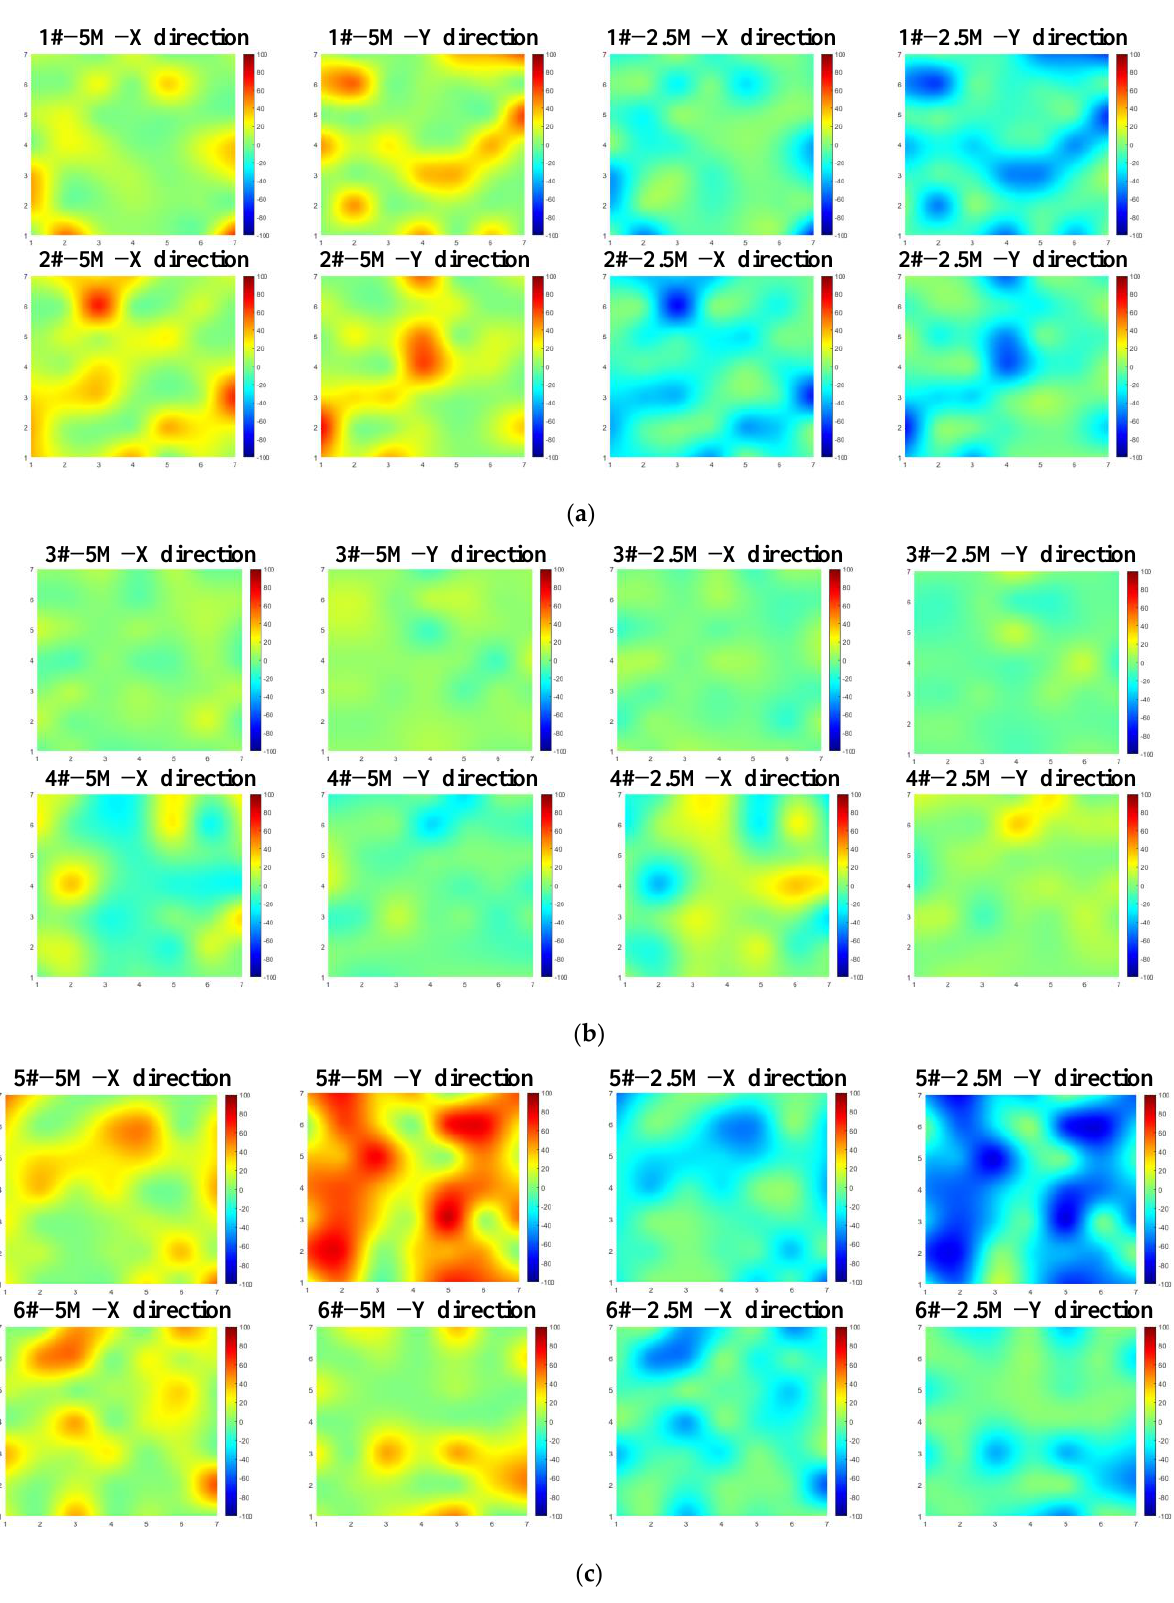
Figure 6. Residual stress distribution cloud diagram of initial blanks. ( a ) 5A06 alloy blanks. ( b ) 6061 alloy blanks. ( c ) 7075 alloy blanks.